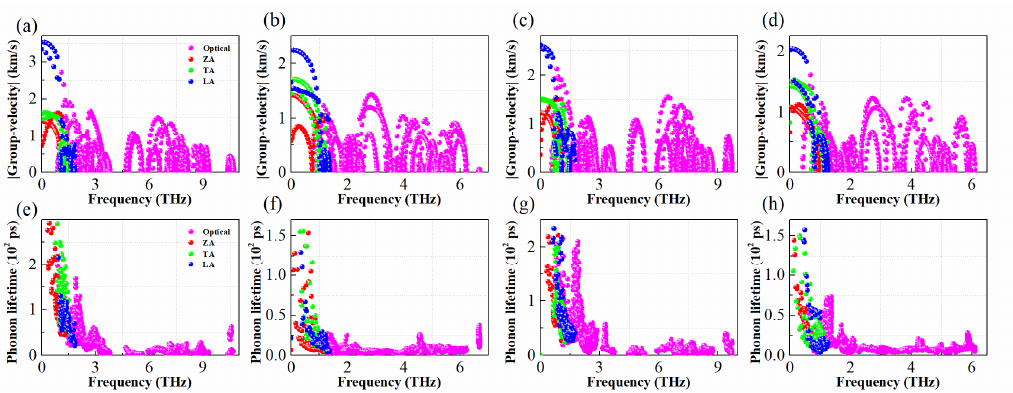
Figure 6. Group velocities ( a – d ) and phonon lifetimes ( e – h ) of 2D CuMN 2 (M = Sb, Bi; N = S, Se), here the red, blue, green, and pink dot correspond to ZA, LA, TA, and Optical phonons, respectively.